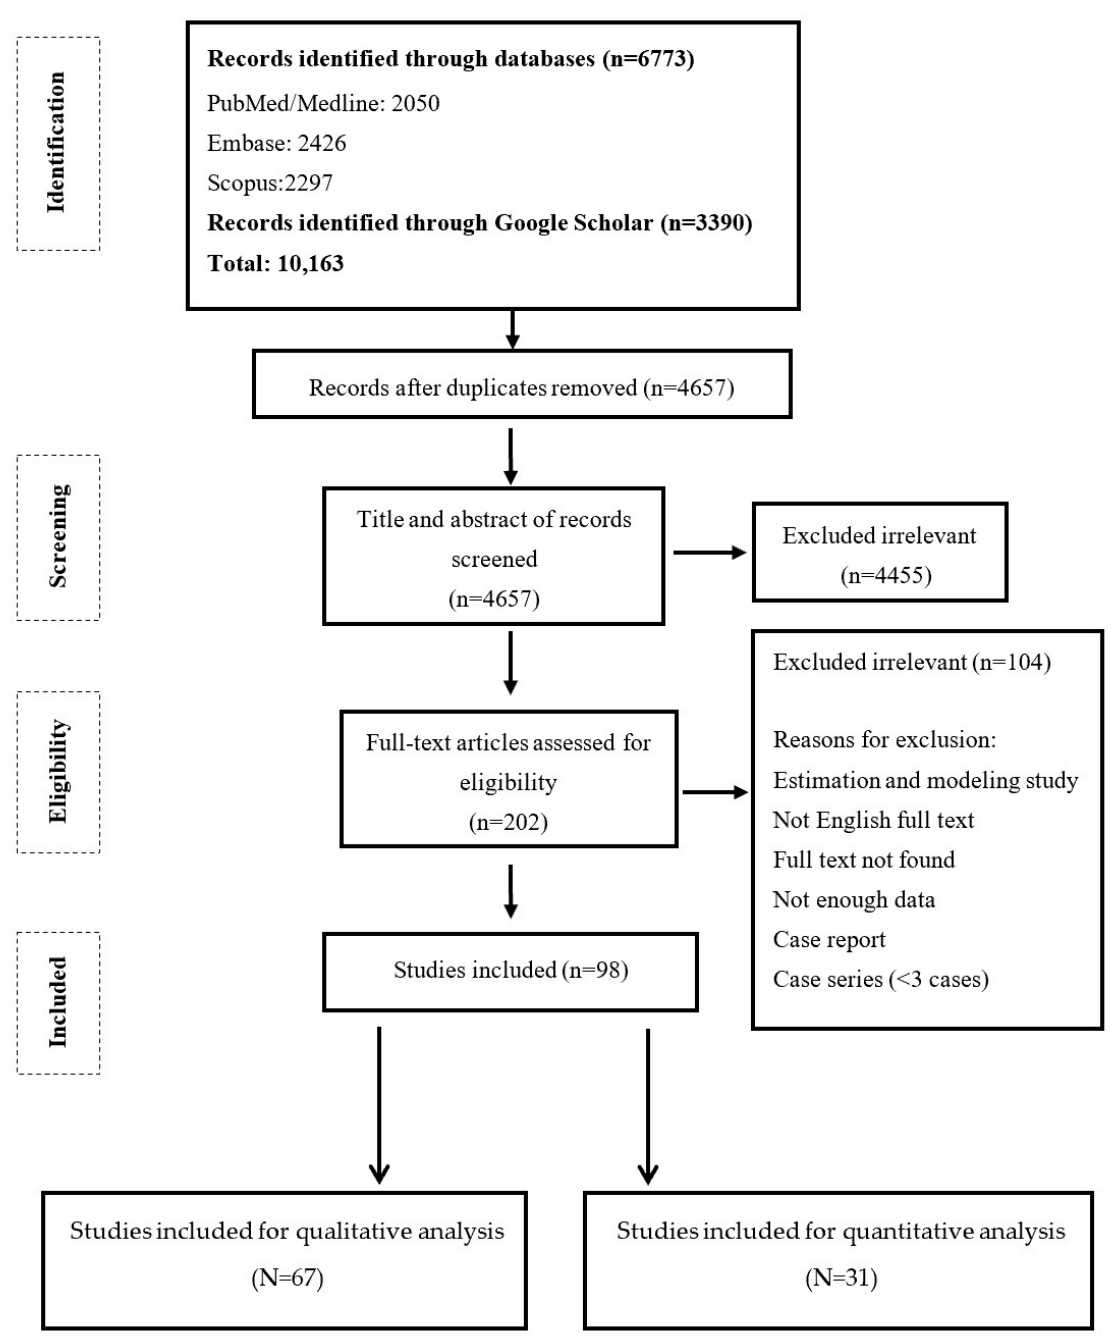
Figure 1. Flow chart of study selection for inclusion in the systematic review and meta ‐ analysis.